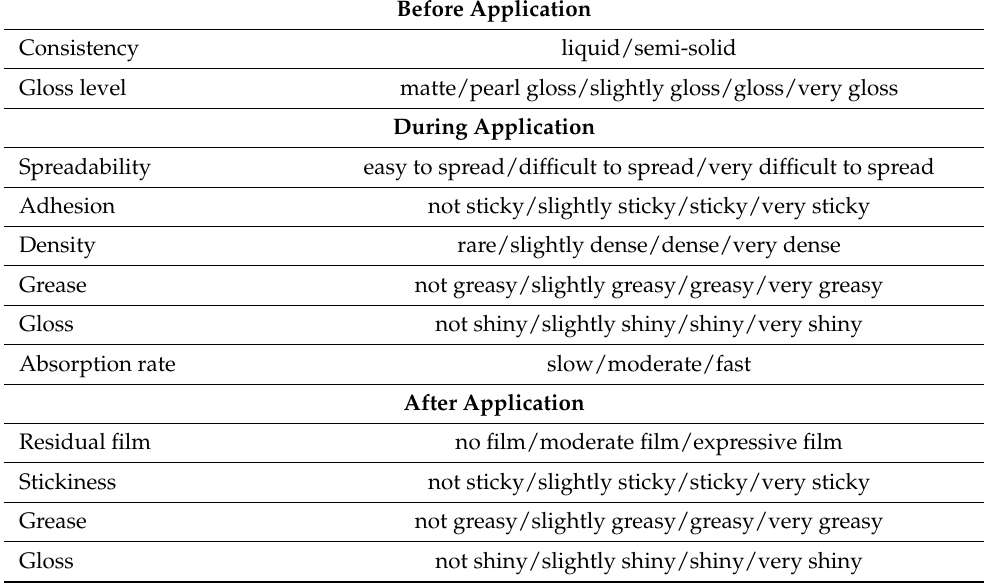
Table 3. Sensory evaluation